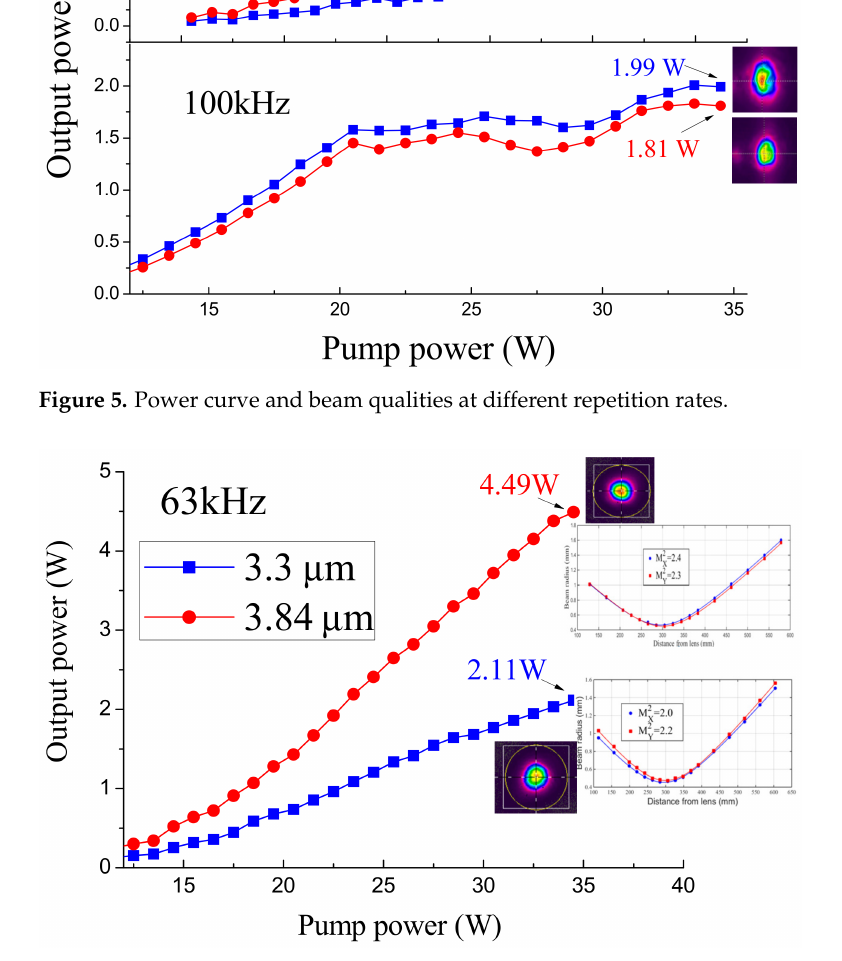
Figure 6. Output power and beam quality at 63